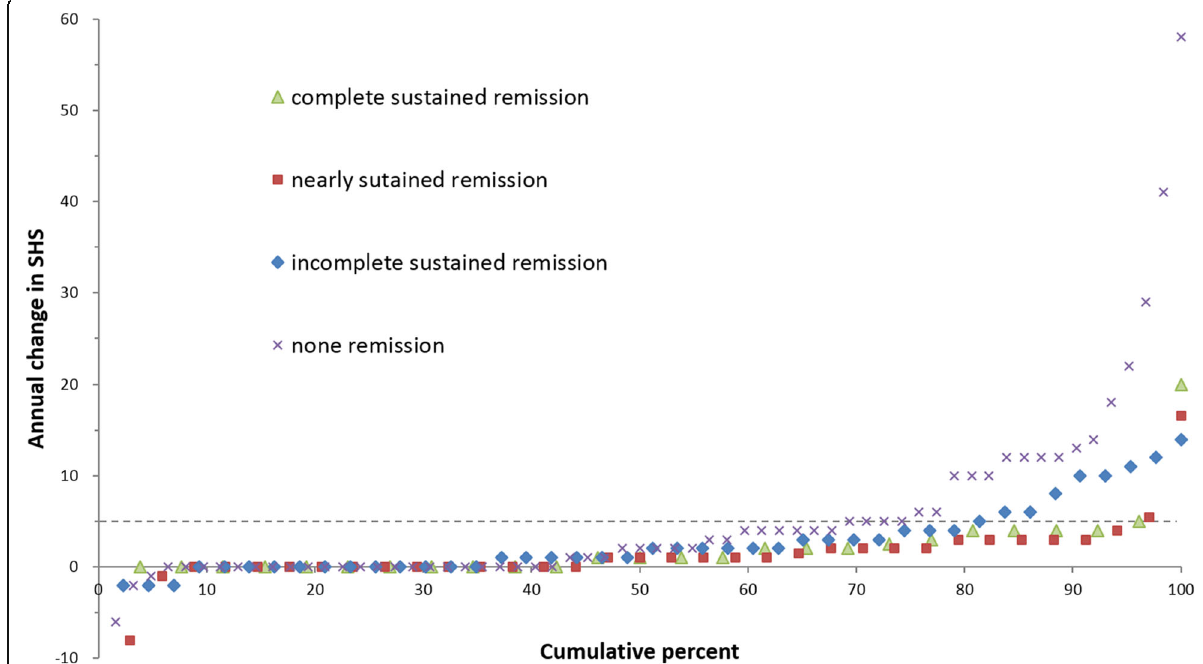
Fig. 1 Cumulative probability plot for patients in sustained remission according to DAS28-ESR criterion during follow-up period